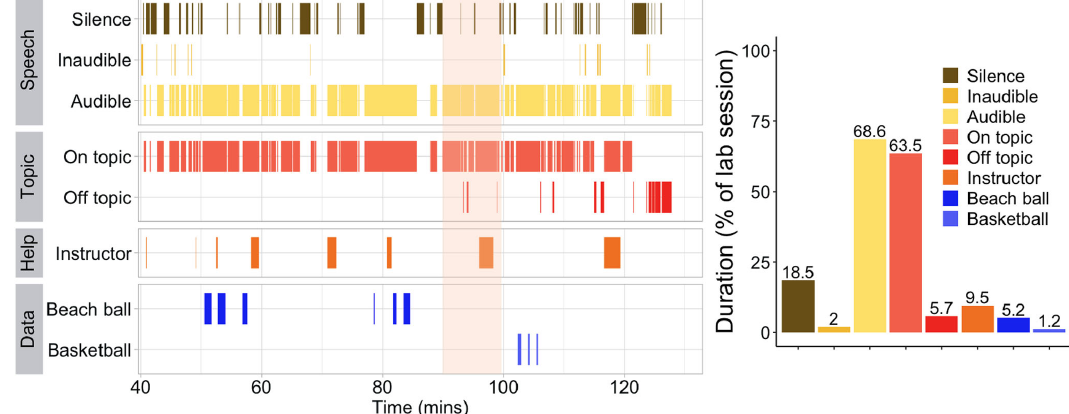
FIG. 10. Group A full timeline highlighting episode analyzed in Ref. [20] and durations of each behavior as a percentage of the video analyzed.